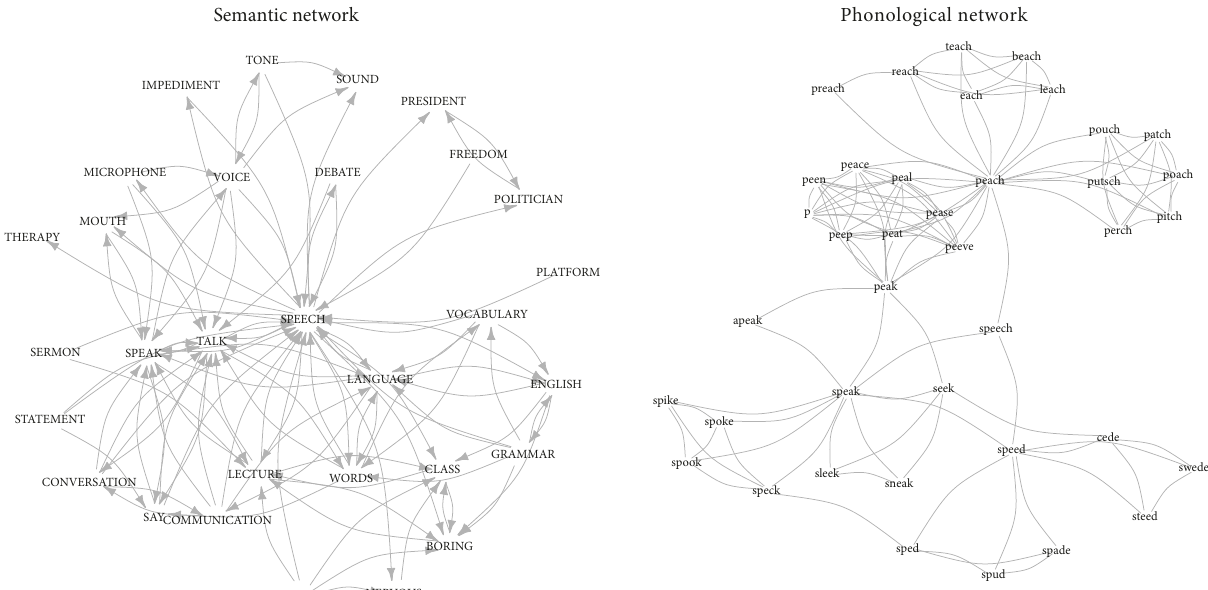
Figure 1: Examples of cognitive networks. Semantic network of free associations to the word speech (Left) and phonological network of words that sound similar to the word speech